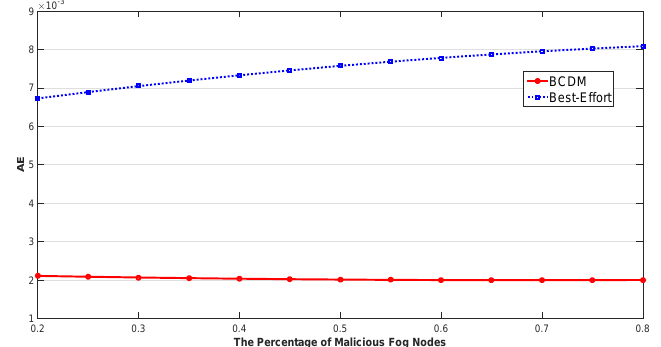
Figure 14. The Impact of the Number of Fog Nodes to Total Number of Allocated Tasks.